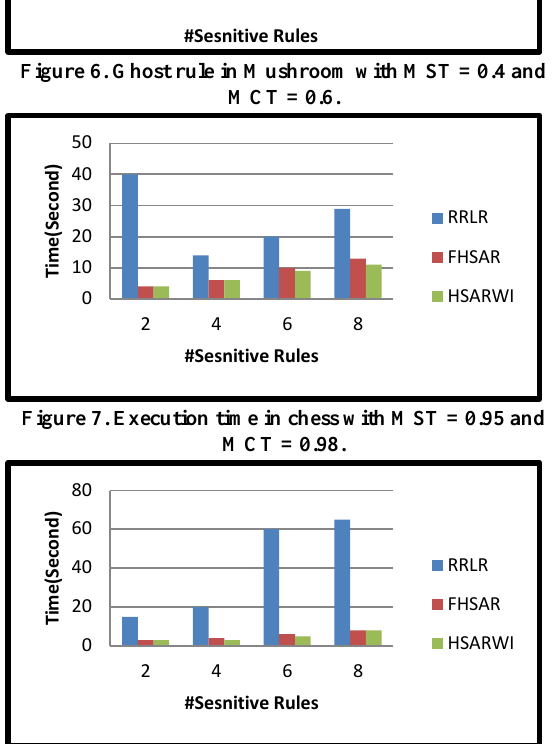
Figure 8. Execution time in chess with MST = 0.88 and MCT =